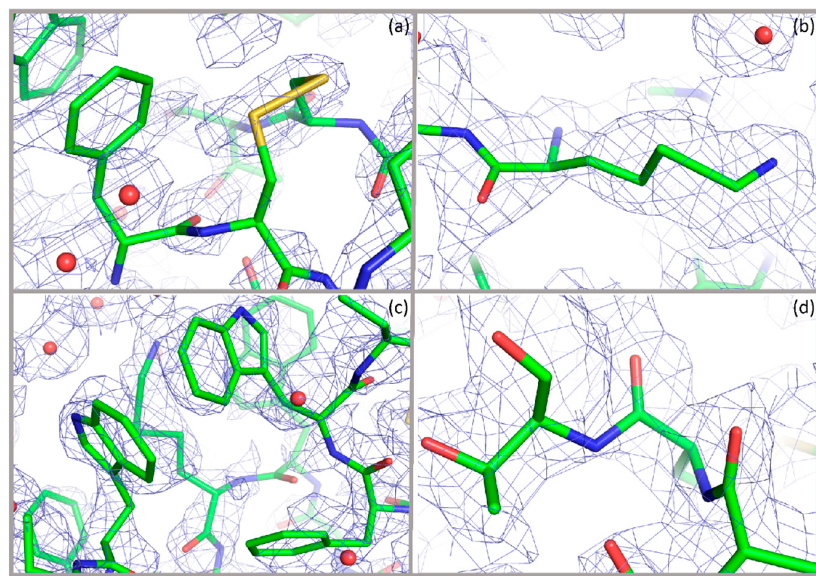
Figure 16. Selected regions of the final structural model of octreotide in stick representation and the corresponding total OMIT map contoured at 1 σ . The green, blue and red colors in the stick representation illustrate C, N and O atoms of di ff erent amino acids, respectively, while water molecules are denoted as red spheres. The four di ff erent panels focus on: ( a ) D-phenylalanine and the disulfide bridge of molecule A; ( b ) L-lysine of molecule A; ( c ) neighboring D-tryptophan residues of molecules B and C and L-phenylalanine of molecule C; ( d ) reduced threonine of molecule C [34].